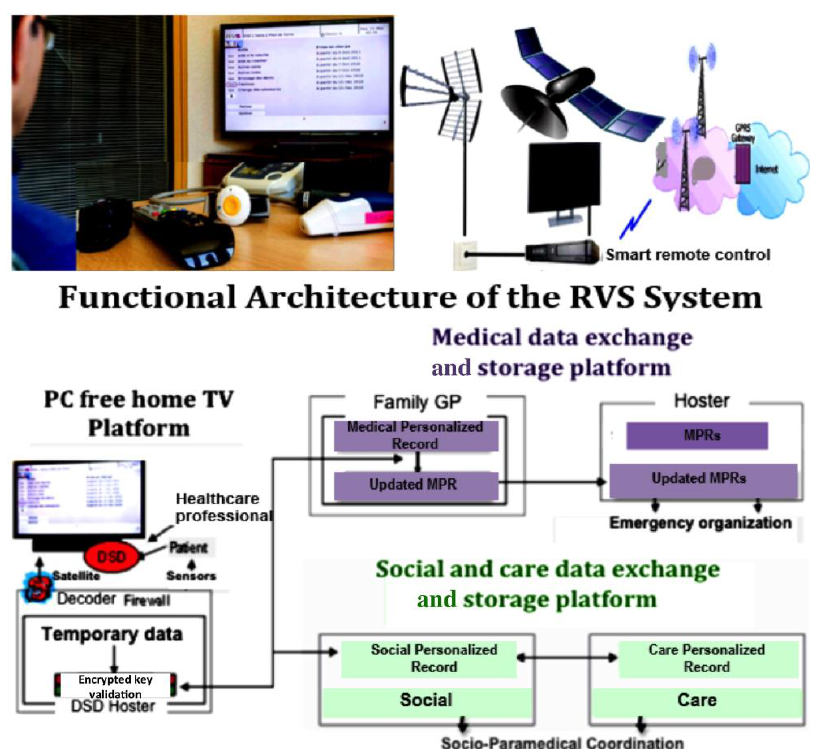
Figure 9. Functional architecture of the Réseau Vercors Santé (RVS) system. Top left: RVS TV screen allowing data recording (using a dedicated smart remote control replacing the PC) and visualization. Top right: satellite communication system using a gateway decoder through a firewall. Bottom left: local temporary repository of personalized medico-social data in a Decoded Signal Data (DSD) Hoster. Bottom right: remote exchange and storage system of medical, social and paramedical data on a common secured host in charge of triggering simultaneously alarms to medical emergency organizations and to the socio-paramedical coordination.